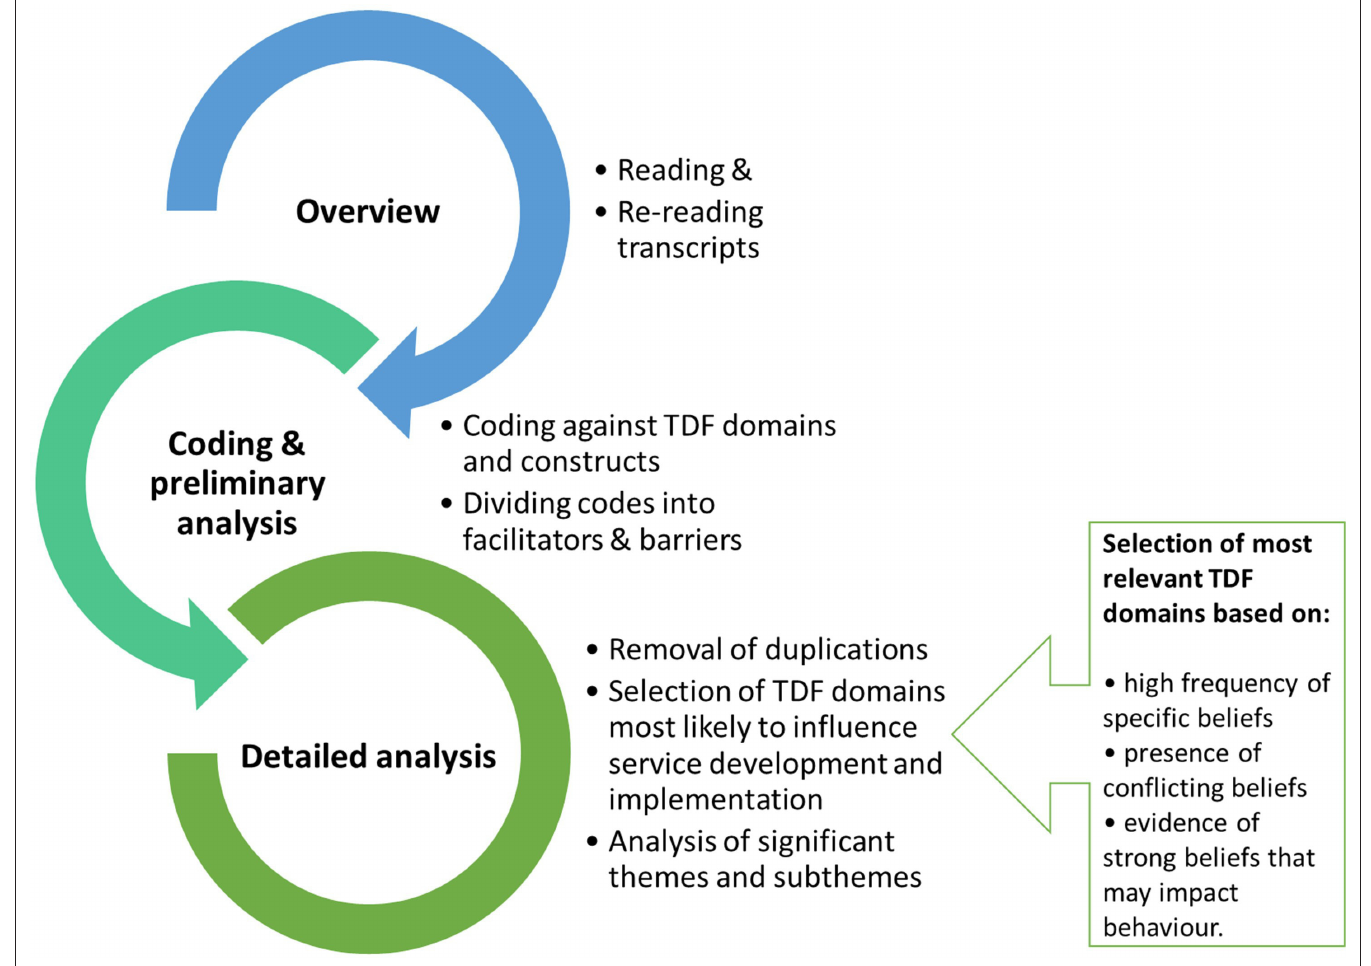
Figure 1 Three- step approach to data analysis based on the Theoretical Domains Framework (TDF) and analytical strategy adapted from Atkins et al 32 and Islam et al 34